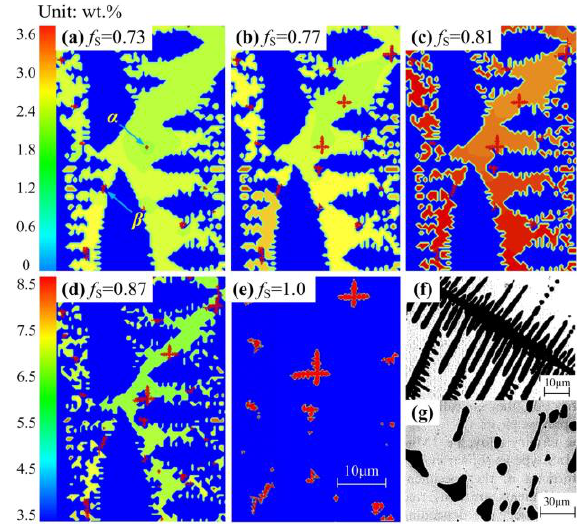
Figure 7. MnS precipitation in Part B and its comparison with experimental observations.